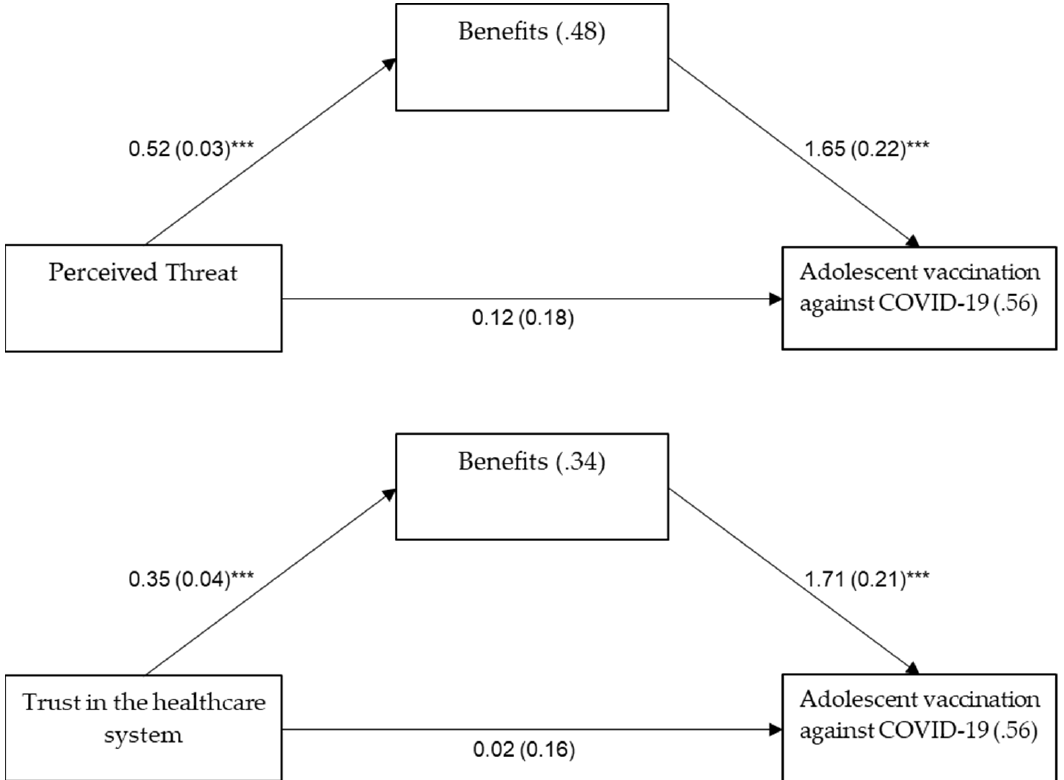
Figure 1. The mediating role of perceived benefits of vaccination in the association between perceived threat and trust in the healthcare system and adolescent vaccination for COVID-19. Note: values on arrows: B(SE), values within rectangles: R 2 or Nagelkerke’s R 2 . *** p < 0.001.